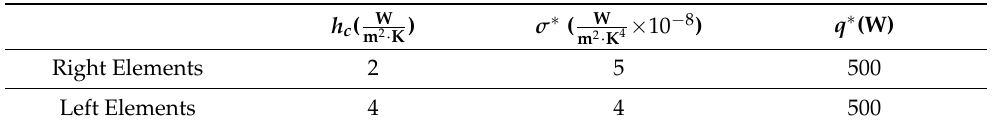
Table 4. The convection, radiation, and heat source characteristics on both sides of the wall compo- nents in the case of the cross-sectional area.